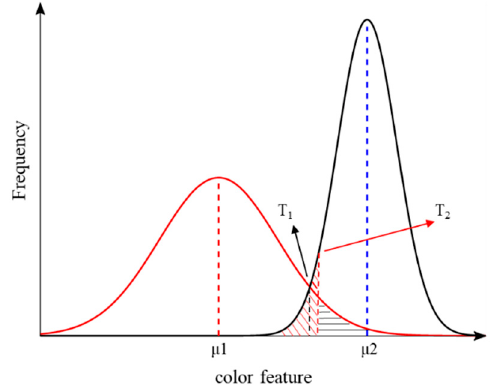
Figure 4. An example of a Gaussian mixture model (GMM) fitted on one color feature with two distinct peaks representing vegetation and backgrounds. The T 1 and T 2 are classification thresholds of vegetation and backgrounds: T 1 represents the intersection of the two Gaussian distributions; T 2 represents the point at which the misclassification probability for vegetation (zone covered with red lines) and backgrounds (zone covered with black lines) is equal.